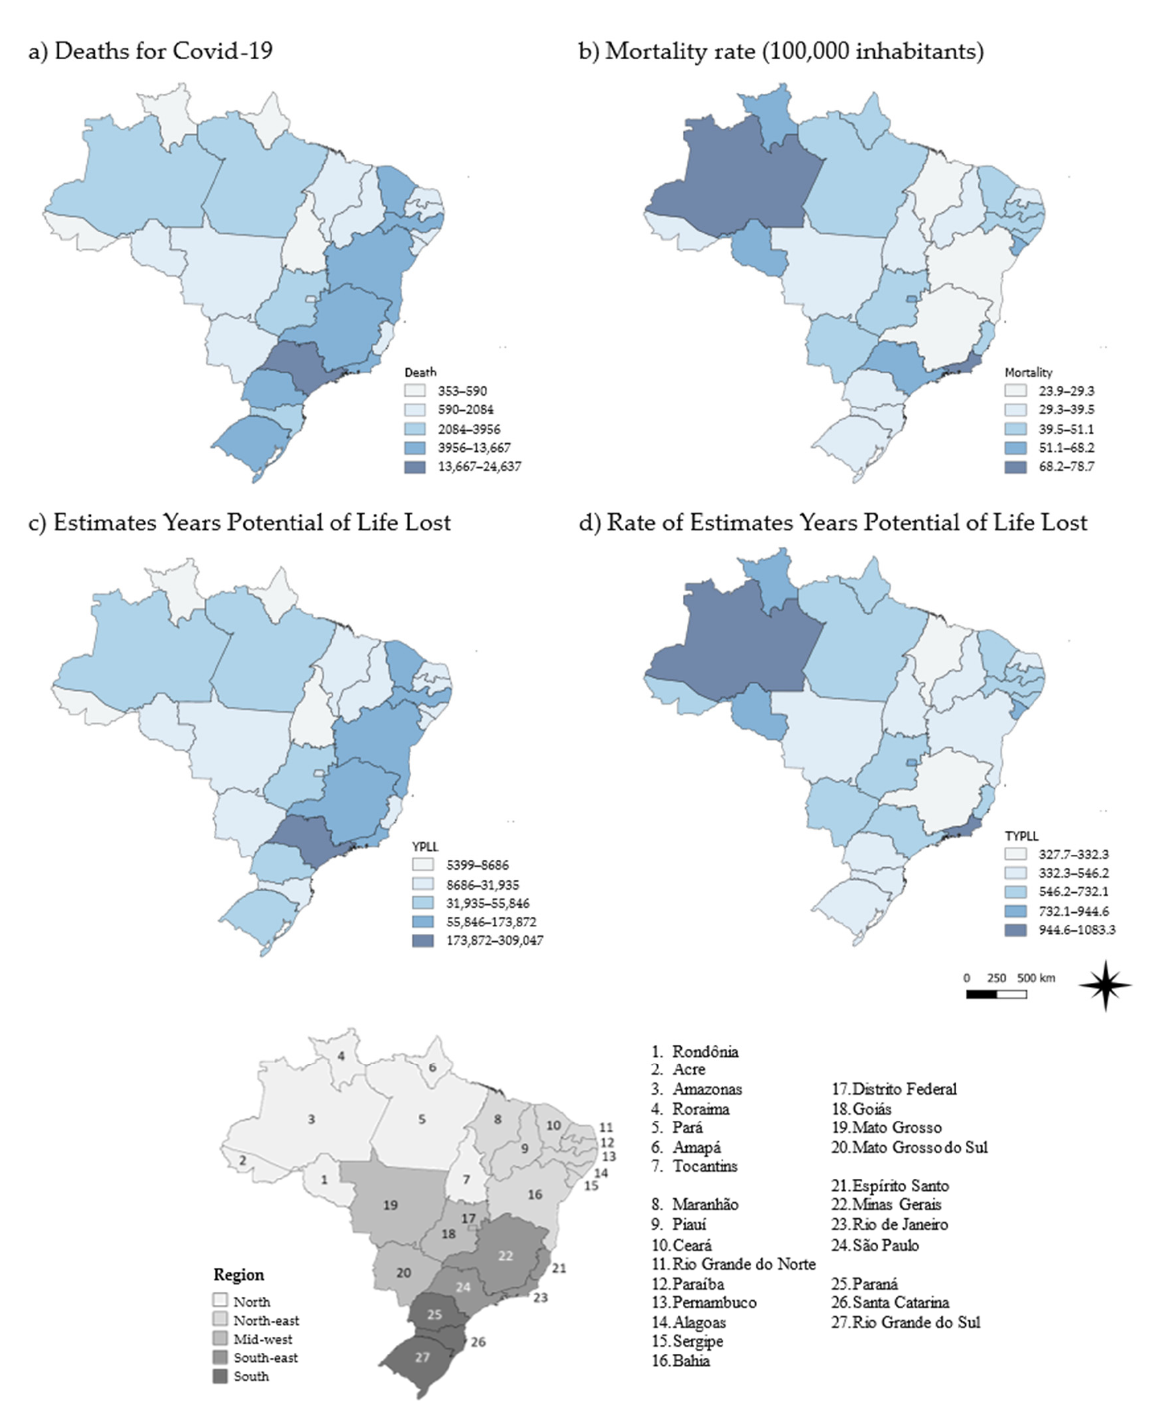
Figure 1. Fatalities and years of potential life lost due to COVID-19 in Brazil (2020) by region and state of residence.